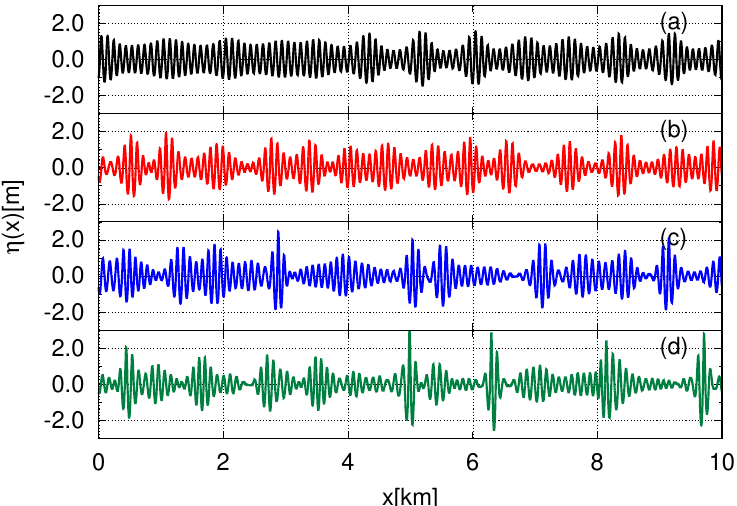
Figure 8. Simulations in the framework of the fully nonlinear model at large times. Different panels show snapshots of the free surface at: ( a ) t ≈ 15.3 h ( b ) t ≈ 20.5 h ( c ) t ≈ 40 h and ( d ) t ≈ 55.5